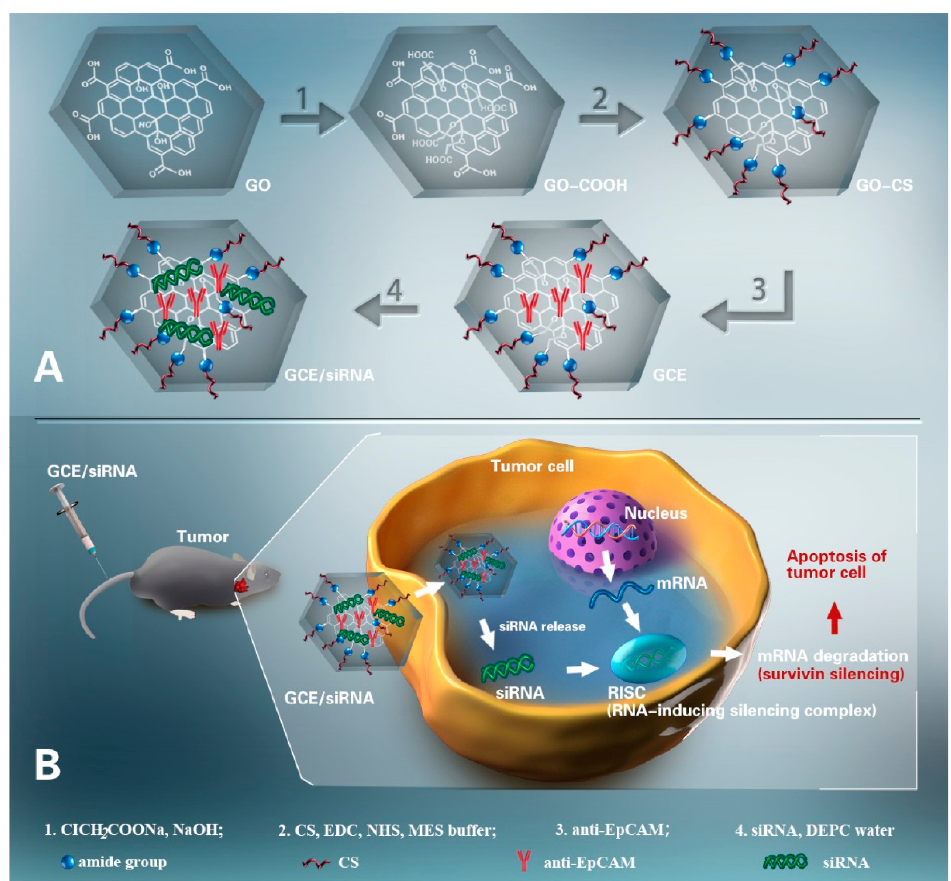
Figure 5. Schematic representation of the delivery system designed by Chen et al. ( A ) Nanosystem fabrication. ( B ) Mechanisms of action. Reprinted from an open-access source [52]. Abbreviations: